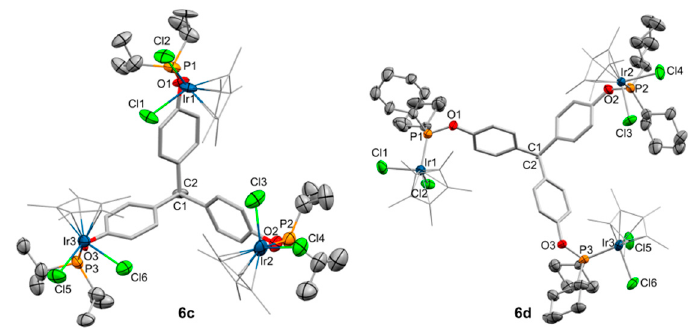
Figure 6. ORTEP view of the solid structure of compounds 6c and 6d with thermal ellipsoids set at 50% probability. Hydrogen atoms and solvent molecules have been excluded for the sake of clarity. Selected bond distances (Å) and angles ( ◦ ): Compound 6c : Ir1–P1, 2.295(6); Ir2–P2, 2.296(7); Ir3–P3, 2.302(8);